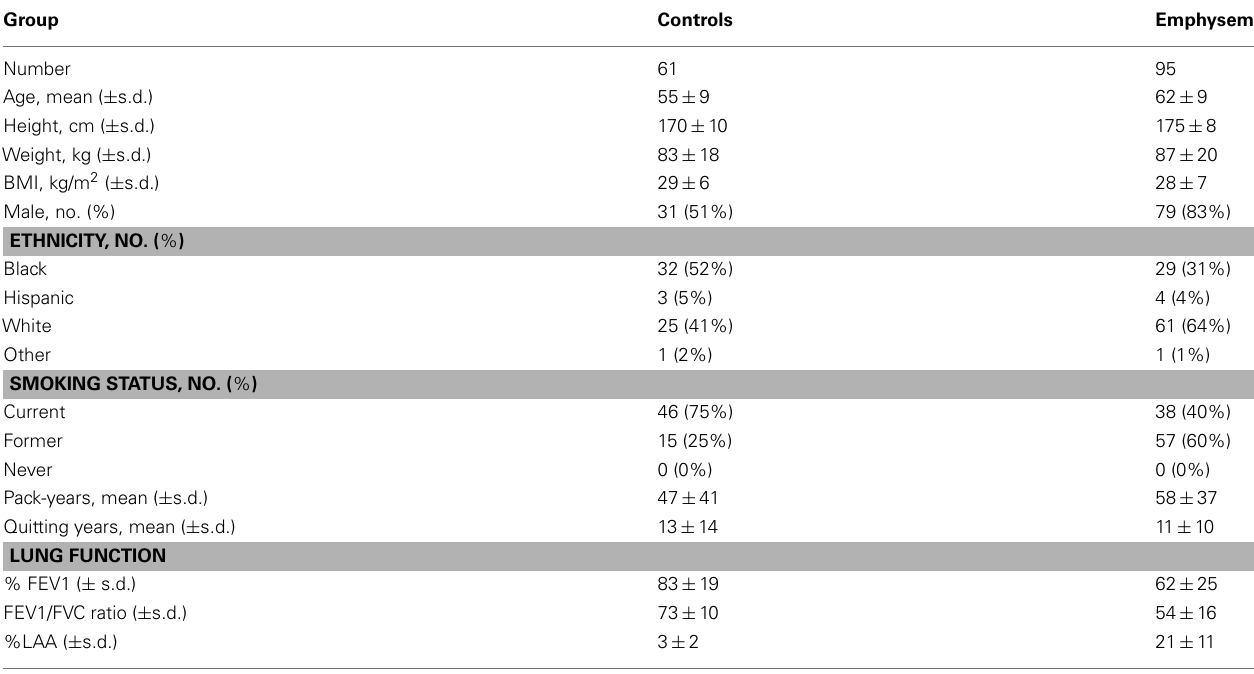
TableA1 | Clinical and demographic information of the study participants. Group Controls Emphysema Number 61 95 Age, mean ( ± s.d.) 55 ± 9 62 ± 9 Height, cm ( ± s.d.) 170 ± 10 175 ± 8 Weight, kg ( ± s.d.) 83 ± 18 87 ± 20 29 ±